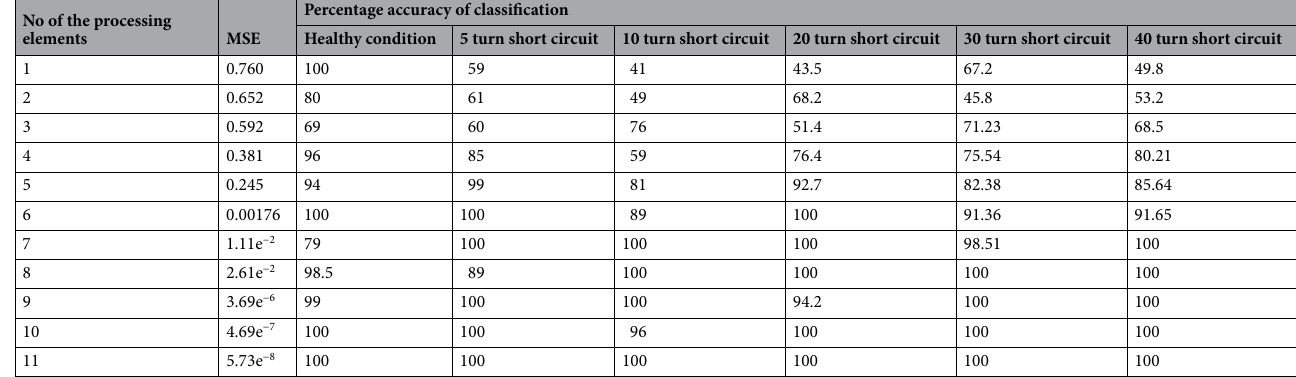
Table 5. Percentage accuracy of classification based on number of processing elements and MSE for ANN (for testing and cross validation data set).